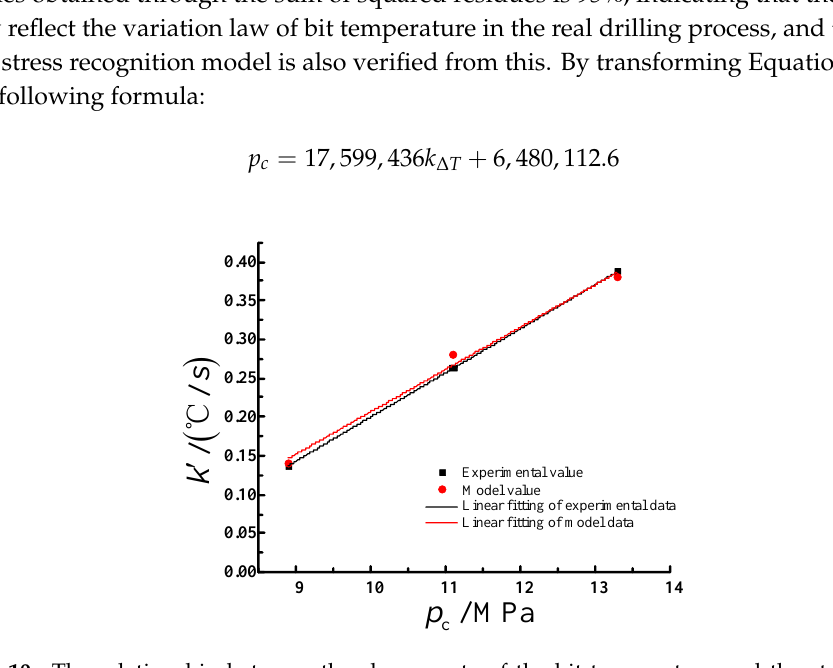
Figure 10. The relationship between the change rate of the bit temperature and the stress of the coal body.